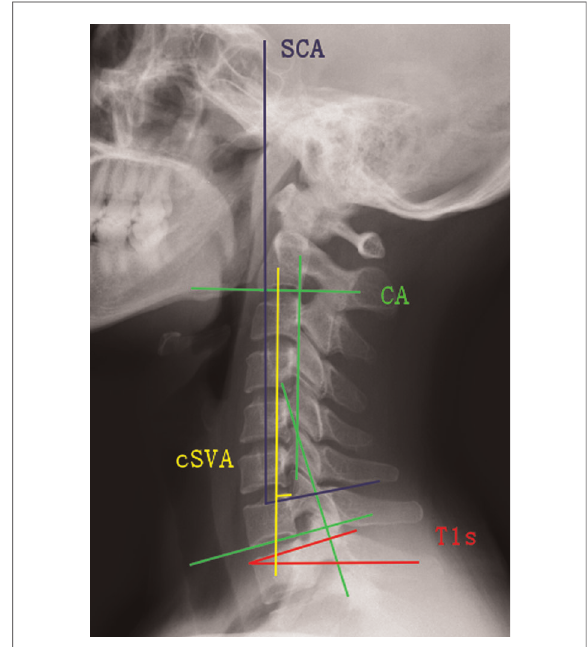
FIGURE 1 Spinocranial angle (SCA): the angle is de fi ned as the angle between the C7 slope and the straight line joining the middle of the C7 end plate and the middle of the sella turcica. T1 slope (T1s): the angle between a horizontal line and the superior endplate of T1 or C7. C2 – C7 lordosis (CL): the angle between the lower plate of C2 and the lower plate of C7. C2 – C7 SVA (cSVA): the distance from the posterior, superior corner of C7 to the plumbline from the centroid of